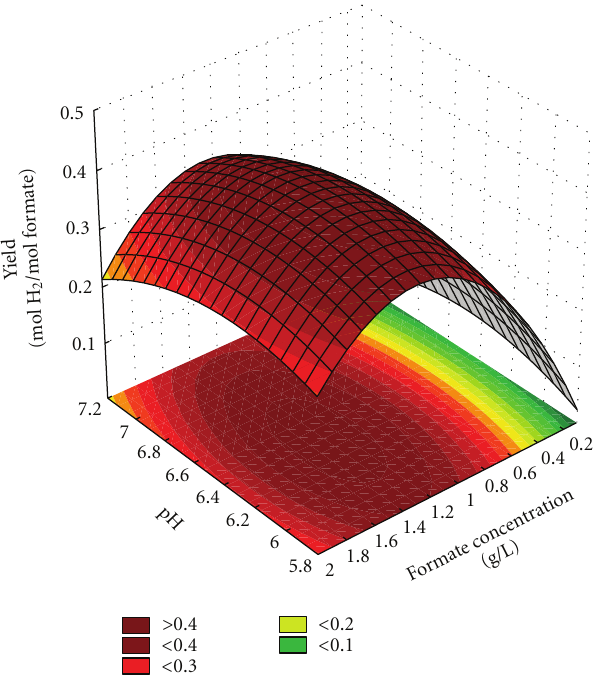
Figure 3: The response surface and contour plot of pH and formate concentration on hydrogen yield for E. coli (XL1-BLUE).